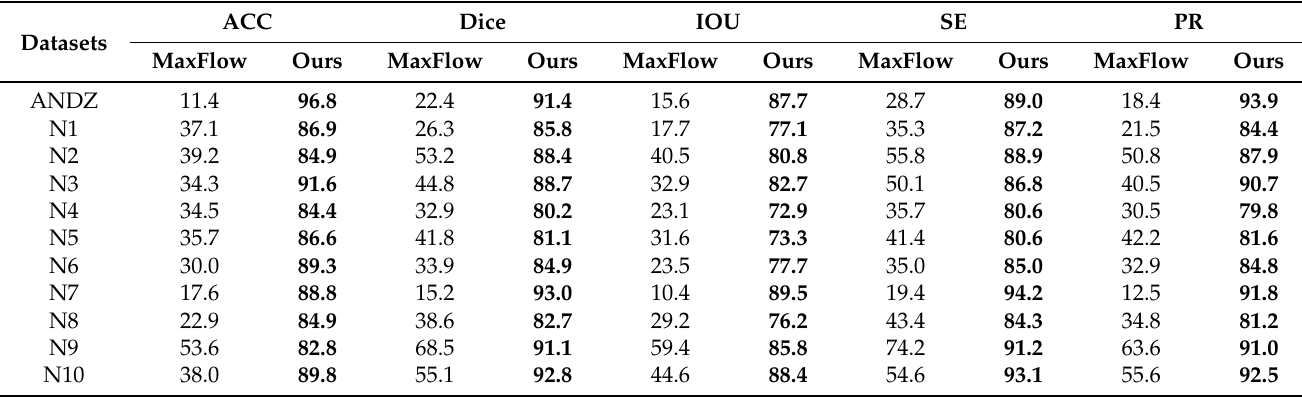
Table 2. Comparison results. Results are compared with MaxFlow [10] in terms of ACC, Dice, IOU, SE, and